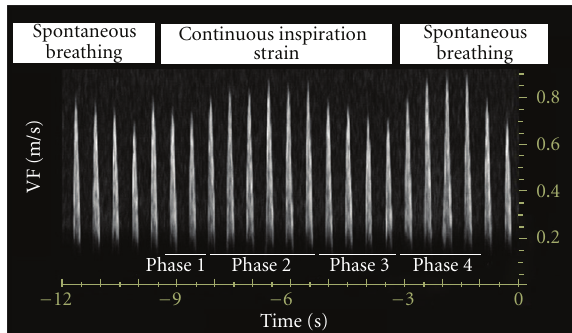
Figure 1: Velocity peak of femoral artery flow (VF) during a deep inspiration maneuver (DIM). Phase 1, 2, 3, and 4 of the DIM.